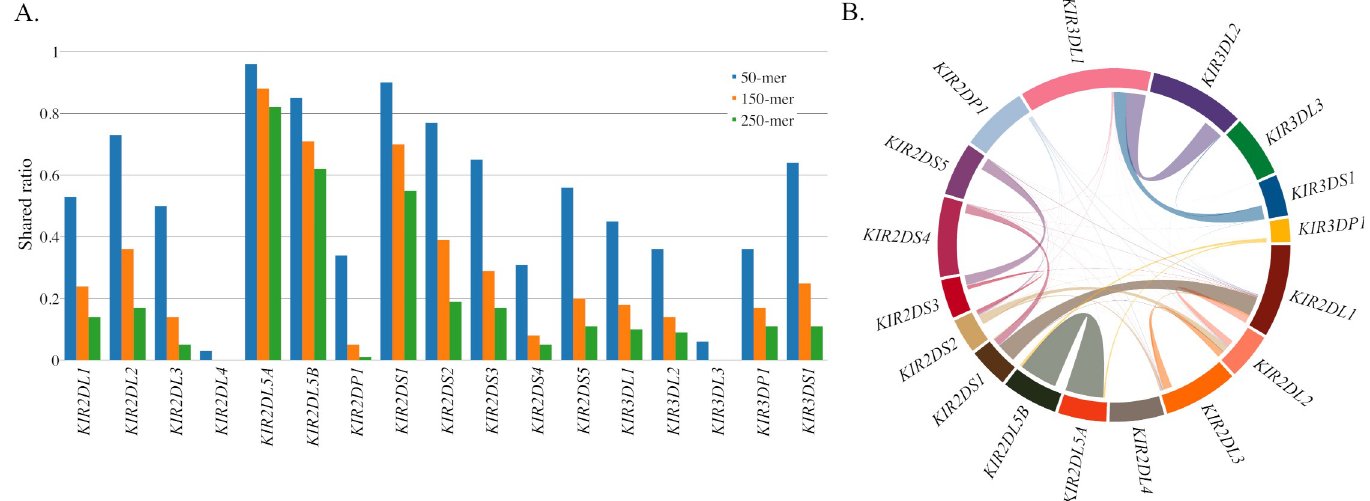
Fig 4. K-mer analysis of KIR gene sequence similarity. (A) Ratio of distinct k-mers of size 50, 150 and 250 that are shared between the indicated KIR gene and others. The inverse of these bars (not shown) would indicate the proportion of k-mers that are distinct to that gene and not found in the alleles of other genes. (B) 150-mer connections between KIR genes, the size of the connecting line roughly indicates the total number of shared 150-mers.